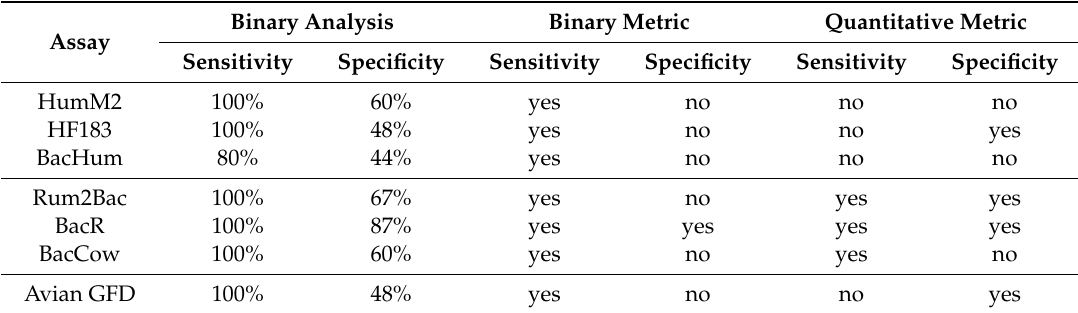
Table 2. Sensitivity and specificity of the MST source-specific assays as concluded from the binary analysis, and whether assay is deemed sensitive or specific based on binary and quantitative metrics. Binary Analysis Binary Metric Quantitative Assay